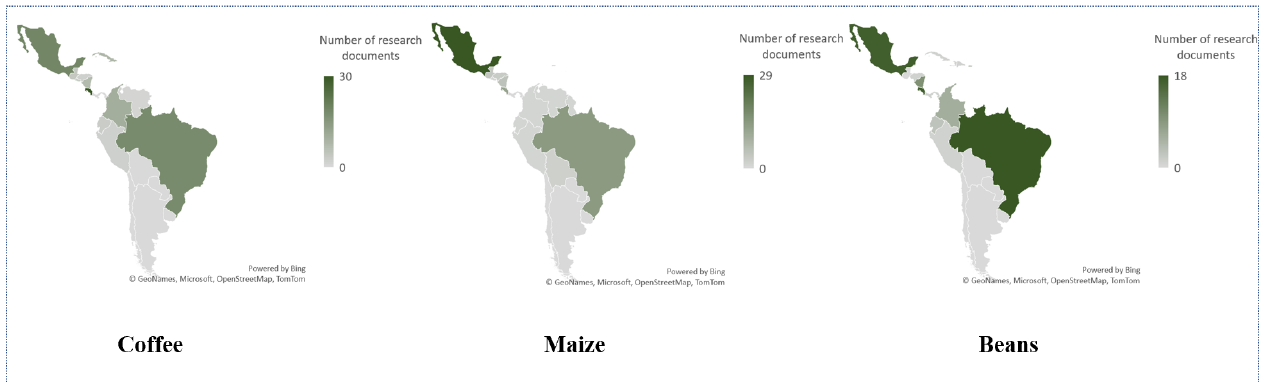
Figure 1. Number and geographical distribution across Latin America of the research documents analyzed for coffee n = 120, maize n = 99 and beans n = 85.